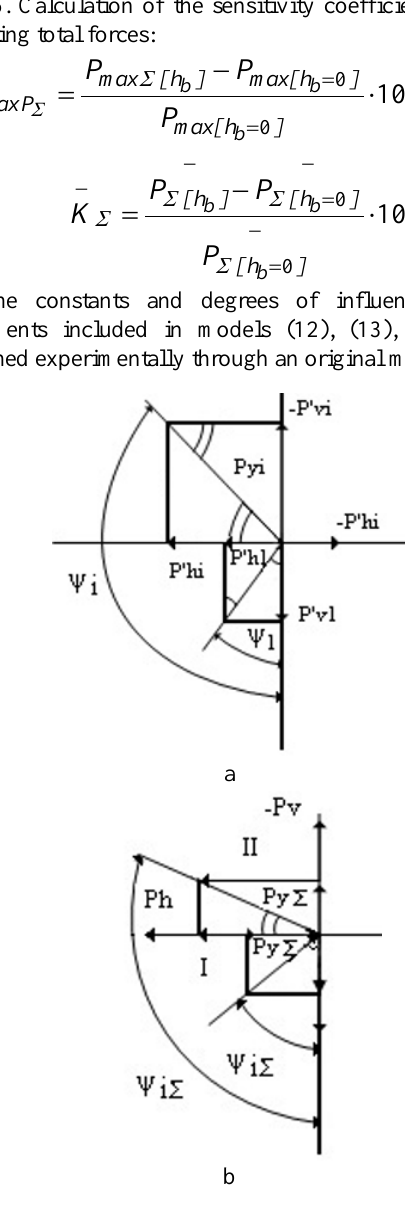
Fig. 3. Force vectors acting on the face milling cutter inserts: a) to calculate the total forces; b) to calculate the angular